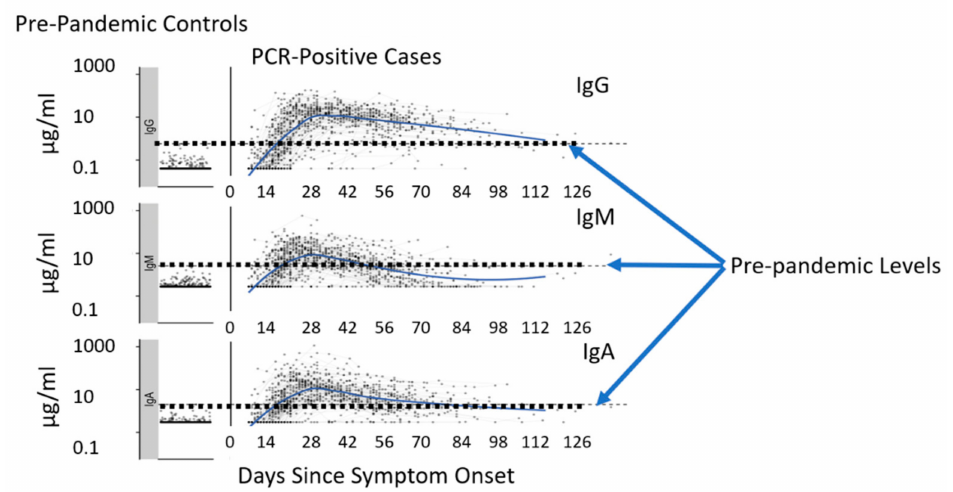
Figure 4. COVID-19 pre-pandemic compared with pandemic IgG, IgM and IgA anti- body levels.